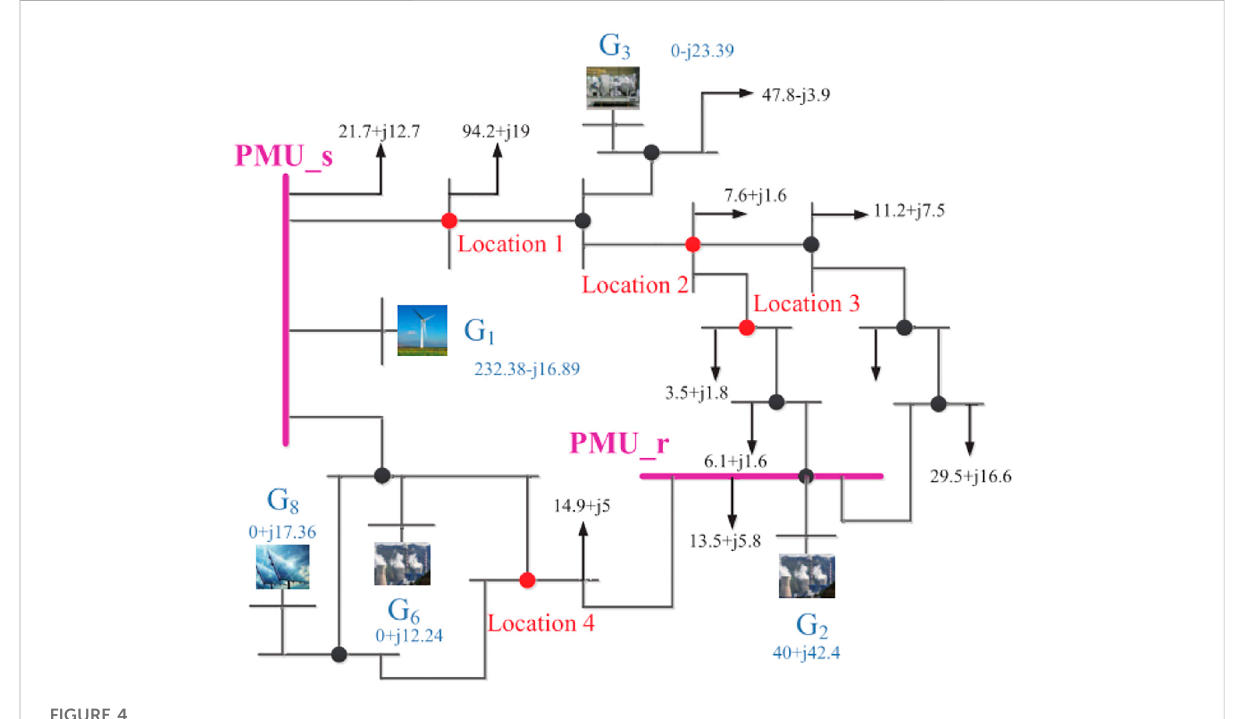
FIGURE 4 Simulation model built in